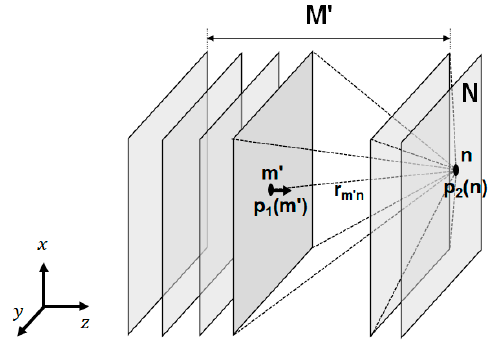
Figure 2. Model of the second harmonic pressure field calculation method.